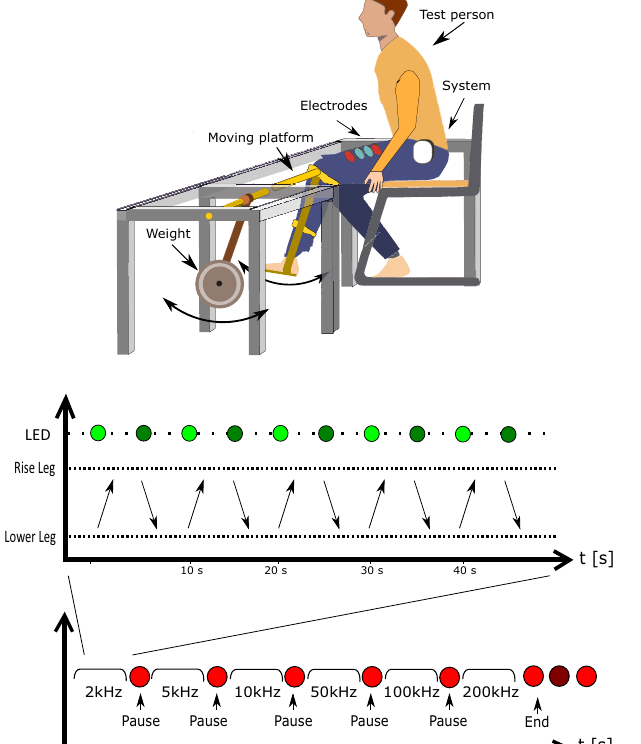
Figure 10. Top : setup of muscle contraction test on the test bench; bottom : protocol of muscle contraction test on the test